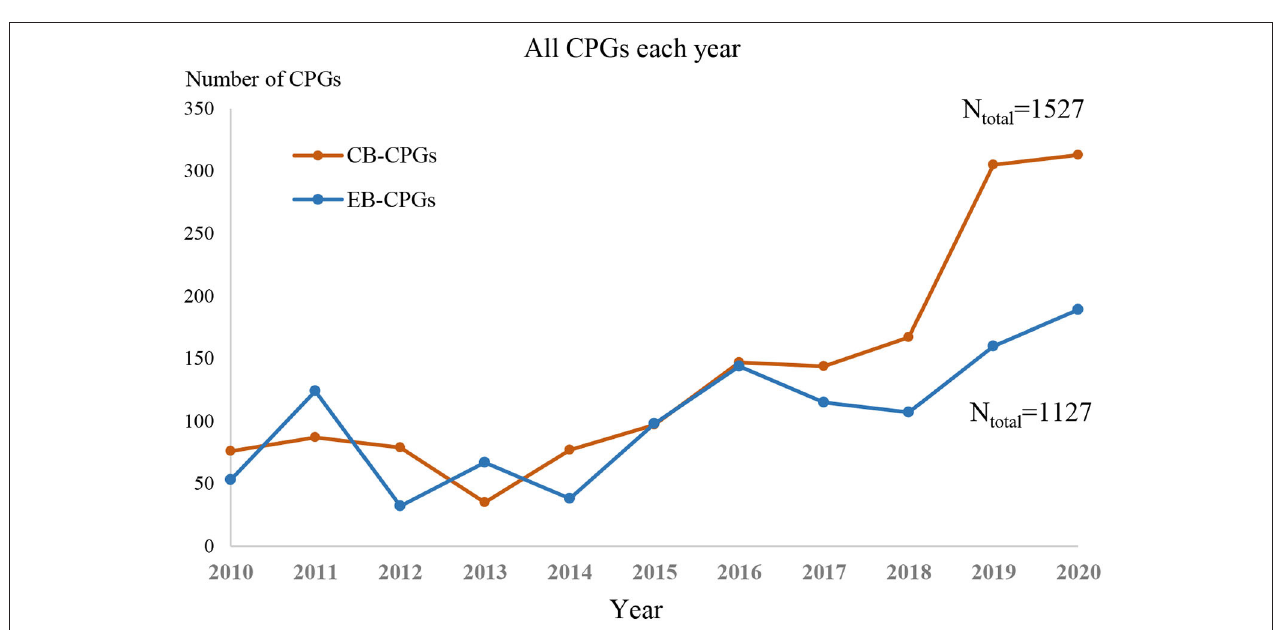
FIGURE 2 | The publication trends of the guidelines from 2010 to 2020.